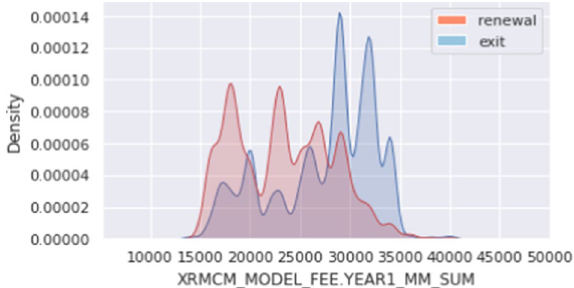
Fig. 7 Results of comparative analysis by renewal (Y/N)—1st year monthly fee